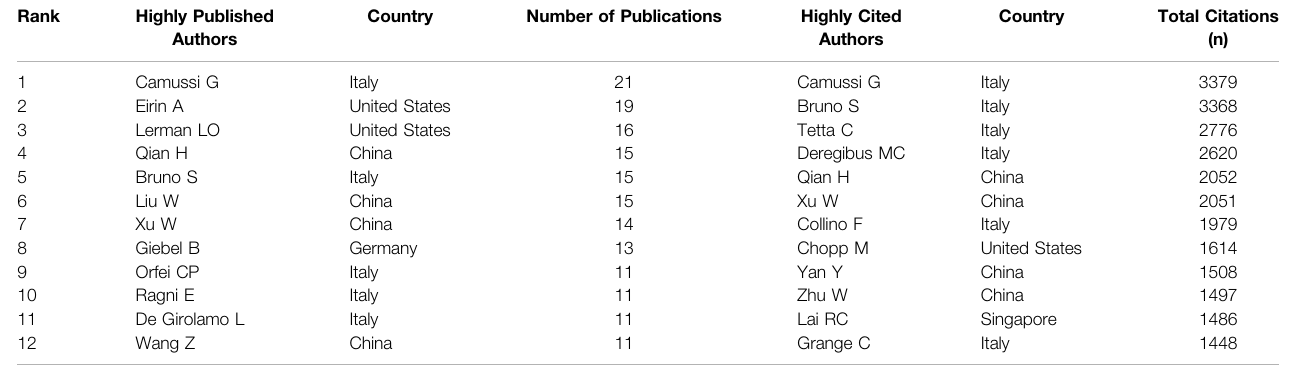
TABLE 4 | The top 12 authors with the most publications and citations on MSC-EVs research.